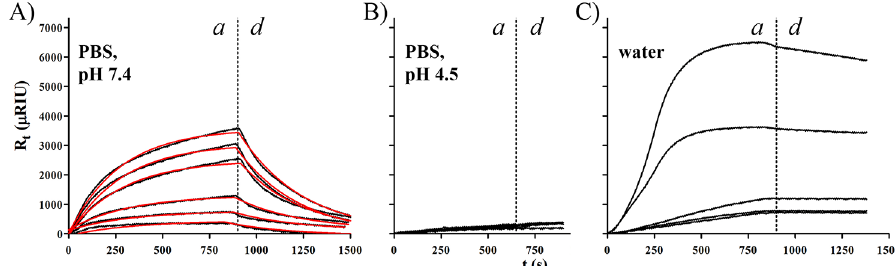
Fig 8. KTN-BMP-2 interaction. Association (a) and dissociation (d) electrostatic interaction profiles of BMP- 2 and the KTN monolayer in PBS and in water. BMP-2 analytes were successively flowed, at incrementally increasing concentrations: A) in PBS (pH 7.4) at 0.2, 0.4, 0.9, 1.7, 3.5, and 6.9 μ M, B) in PBS (pH 4.5) at 0.03, 0.05, 0.1, 0.2, 0.4, 0.9, and 1.7 μ M, and C) in water (pH 7) at 0.03, 0.05, 0.1, 0.2, and 0.4 μ M. KTN-BMP-2 electrostatic attraction was strongest in water (KD = 1.1 × 10 – 7 M). In the presence of PBS salts at physiological pH, binding association was slightly weakened (KD = 3.2 × 10 – 5 M). Acidification of the PBS eliminated any binding between BMP-2 and